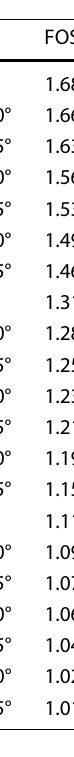
Table 5 The value of the factor of safety in the reinforced and unreinforced states